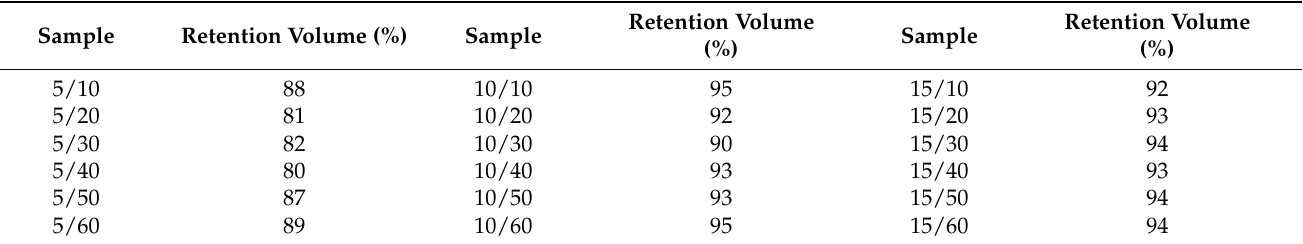
Table 2. The retention volume of modified chitosan nonwovens after treatment in solutions of acetic acid in ethanol—procedure without